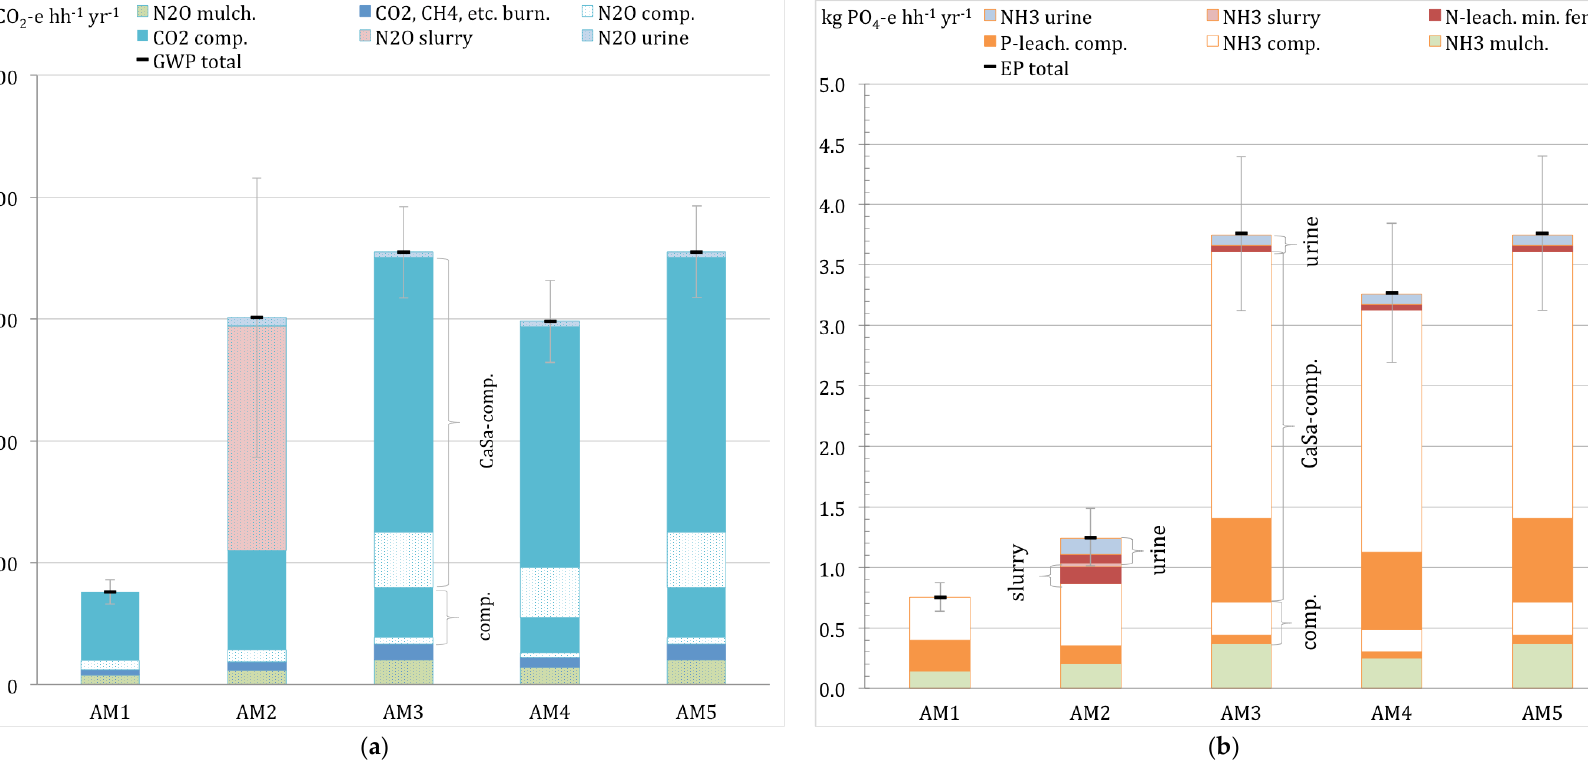
Figure 5. Estimated environmental impacts of the analyzed IPNM strategies: the global warming potential (( a ); left) and the eutrophication potential (( b ); right). Scenarios are defined in Table 1. Plot data provided in Supplementary Tables S13 (Figure 5a) and S14 (Figure 5b). comp.: composting; EP: eutrophication potential; GWP: gobal warming potential; hh: household; leach.: leaching; min. fert.: mineral fertilization.